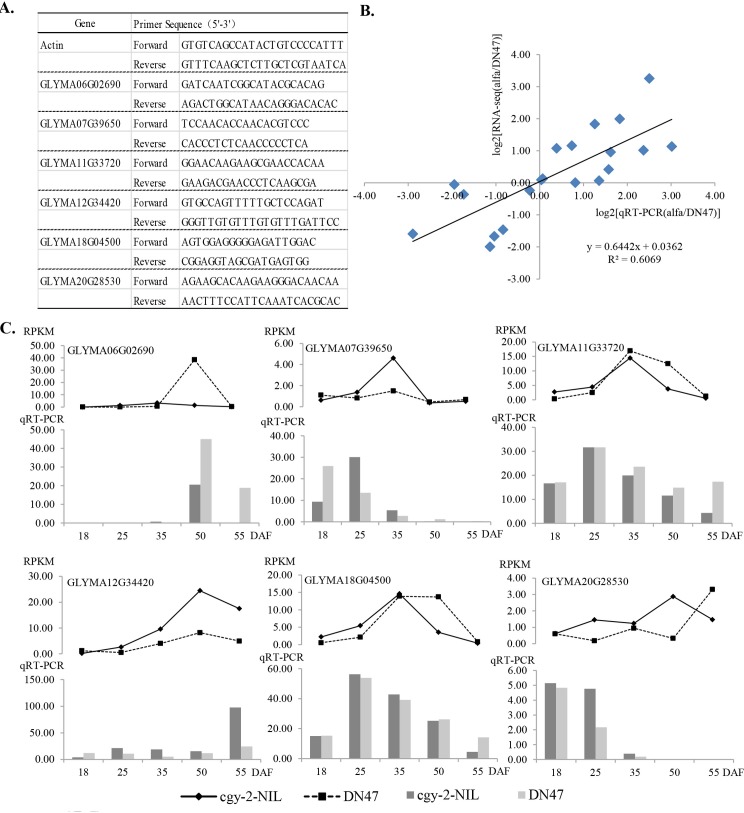
(A) Primer sequences used in quantitative real-time reverse transcription PCR (qRT-PCR) analysis for validation of the expressed genes in Illumina sequencing. (B) Comparison between the gene expression ratios obtained from RNA-seq data and that from qRT-PCR. The RNA-seq log2 value of the expression ratio (y-axis) was plotted against the developmental stages (x-axis). (C) qRT-PCR analysis of differentially expressed genes between cgy-2-NIL and DN47. The transcript abundance from the RNA-seq data is shown at the top of the panel for each gene. RPKM: reads per kilobase per million reads. DAF = days after flowering.